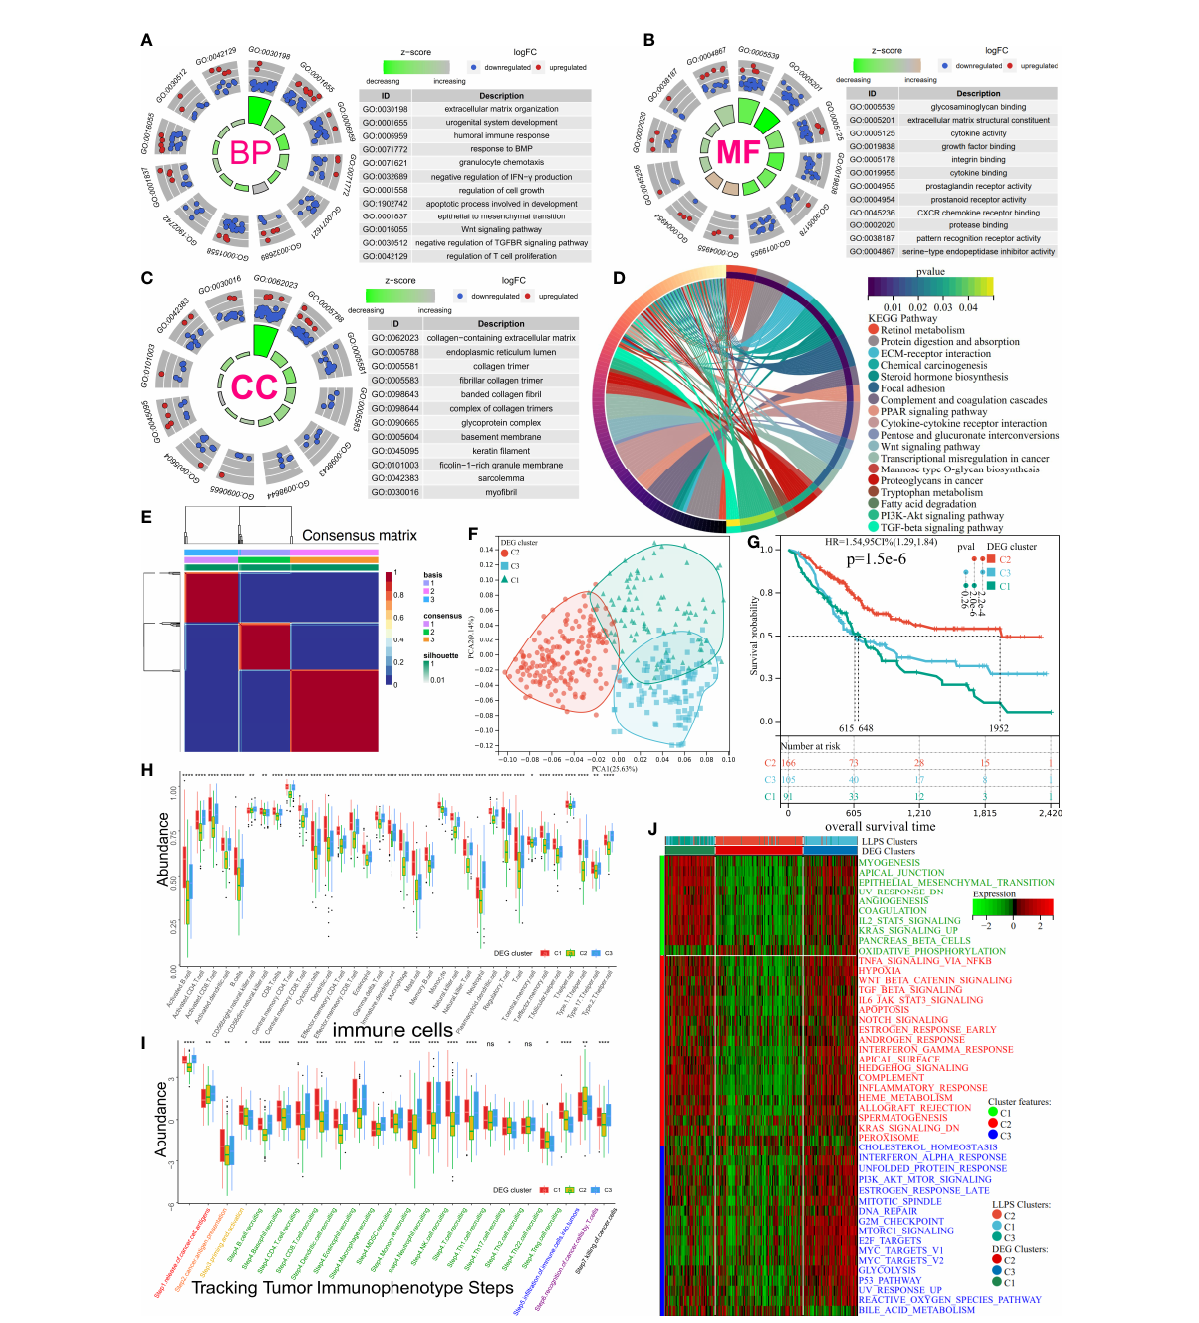
FIGURE 3 Subtype identi fi cation, TME in fi ltration characteristics, and biological signal features of three distinct DEG clusters in BLCA. (A – C) The GO terms enrichment analysis (BP, Biological Process; CC, Cellular Component; MF, Molecular Function) of 470 DEGs. (D) The KEGG pathway enrichment analysis of 470 DEGs. (E) Consensus map of NMF based on 197 prognostic LLPS-related DEGs when k = 3. (F) PCA plot for 197 prognostic LLPS-related DEGs ’ expression. (G) KM curve exhibited signi fi cantly different OS among DEG clusters in TCGA-BLCA cohort. (H, I) Differences in 34 TME-in fi ltrating cells and steps of the cancer immunity cycle among DEG clusters. (J) Heatmap illustrating cancer hallmarks ’ enrichment among three DEG clusters. Red represents high scores, and green represents low scores. The line in the box represents the median value, and the asterisks represent the p-value (*p< 0.05; **p< 0.01; ***p< 0.001; ****p< 0.0001); the statistical analyses were performed by the Kruskal – Wallis test. TME, tumor microenvironment; DEG, differentially expressed gene; BLCA, bladder cancer; GO, Gene Ontology; KEGG, Kyoto Encyclopedia of Genes and Genomes; NMF, non-negative matrix factorization; LLPS, liquid – liquid phase separation; KM, Kaplan – Meier. ns, no signi fi